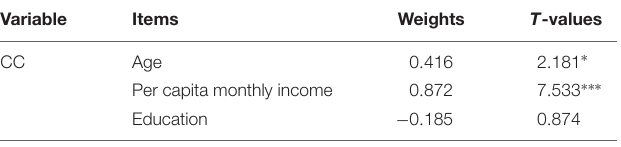
TABLE 3 | Weights and T -values of formative indicators.